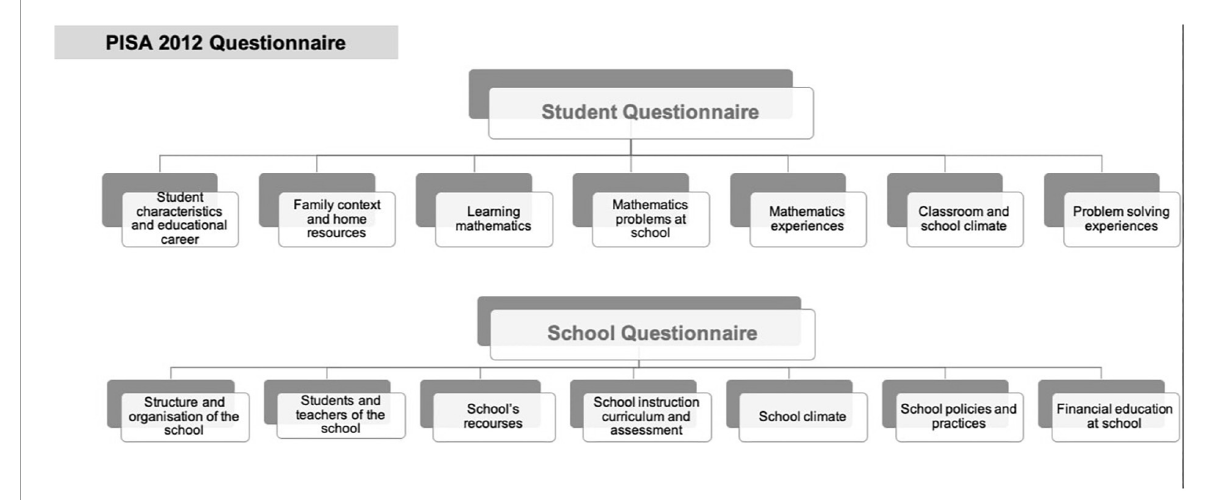
FIGURE3 The main aspects of and student and school questionnaire in programme for international student assessment (PISA 2012).